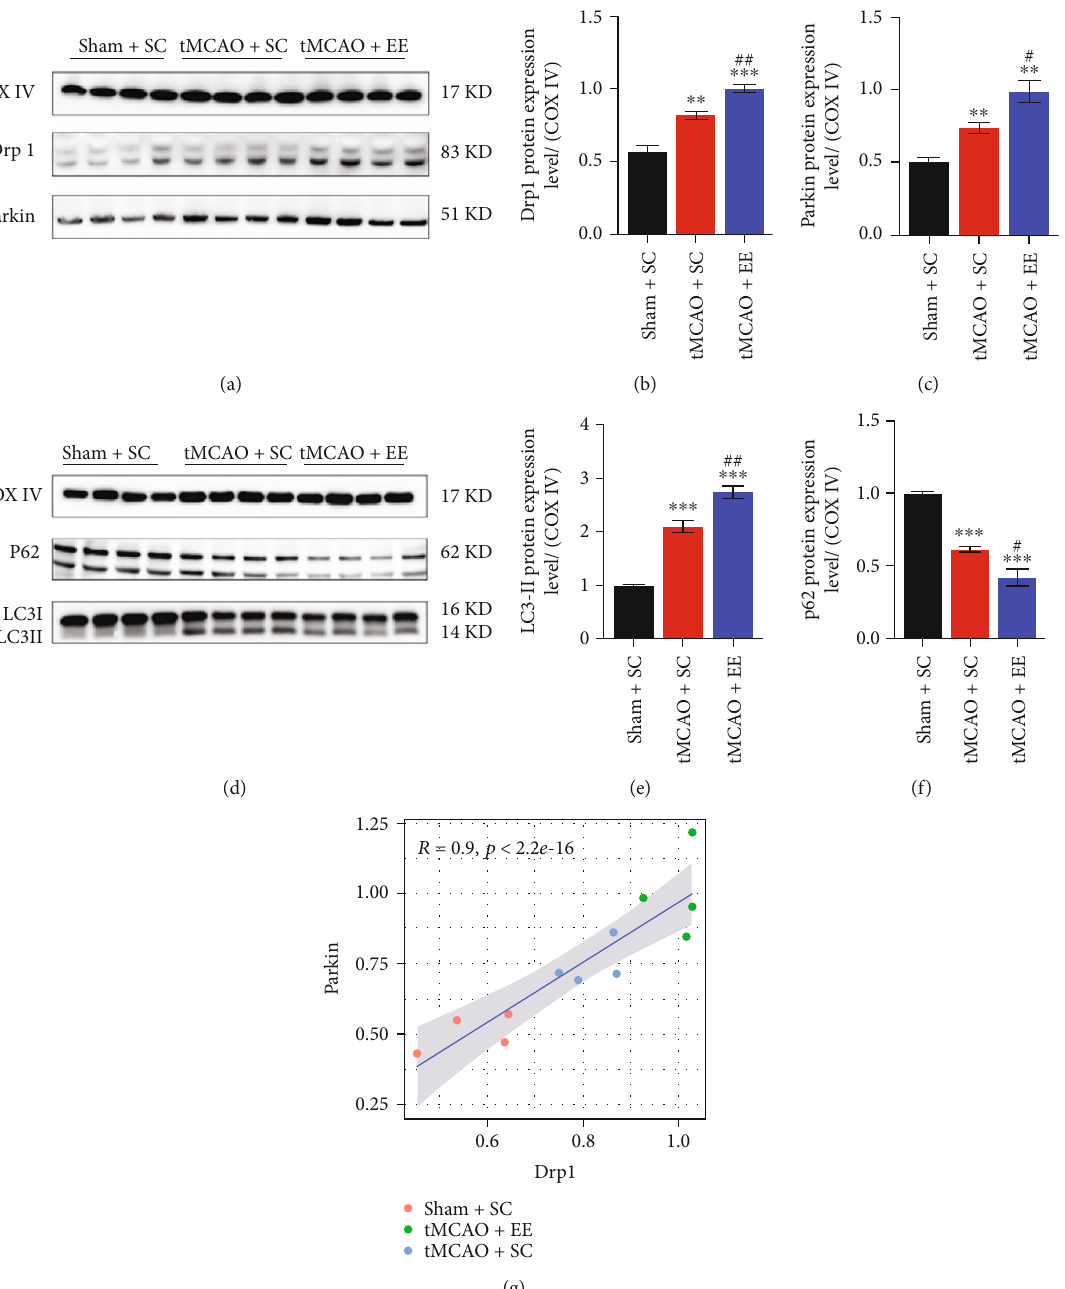
Figure 9: (a, d) Representative mitochondrial protein Western blot images. (b) Comparison of Drp1 protein expression in the mitochondria among the groups. (c) Comparison of Parkin protein expression in the mitochondria among the groups. (e) Comparison of LC3-II protein expression in the mitochondria among the groups. (f) Comparison of p62 protein expression in the mitochondria among the groups. ∗∗ P < 0 : 01 and ∗∗∗ P < 0 : 001 vs . sham+SC group; # P < 0 : 05 and ## P < 0 : 01 vs . tMCAO+SC group. (g) The result of correlation analysis between Drp1 and Parkin; P < 2 : 2 e − 16 and R = 0 : 9 indicate a highly positive